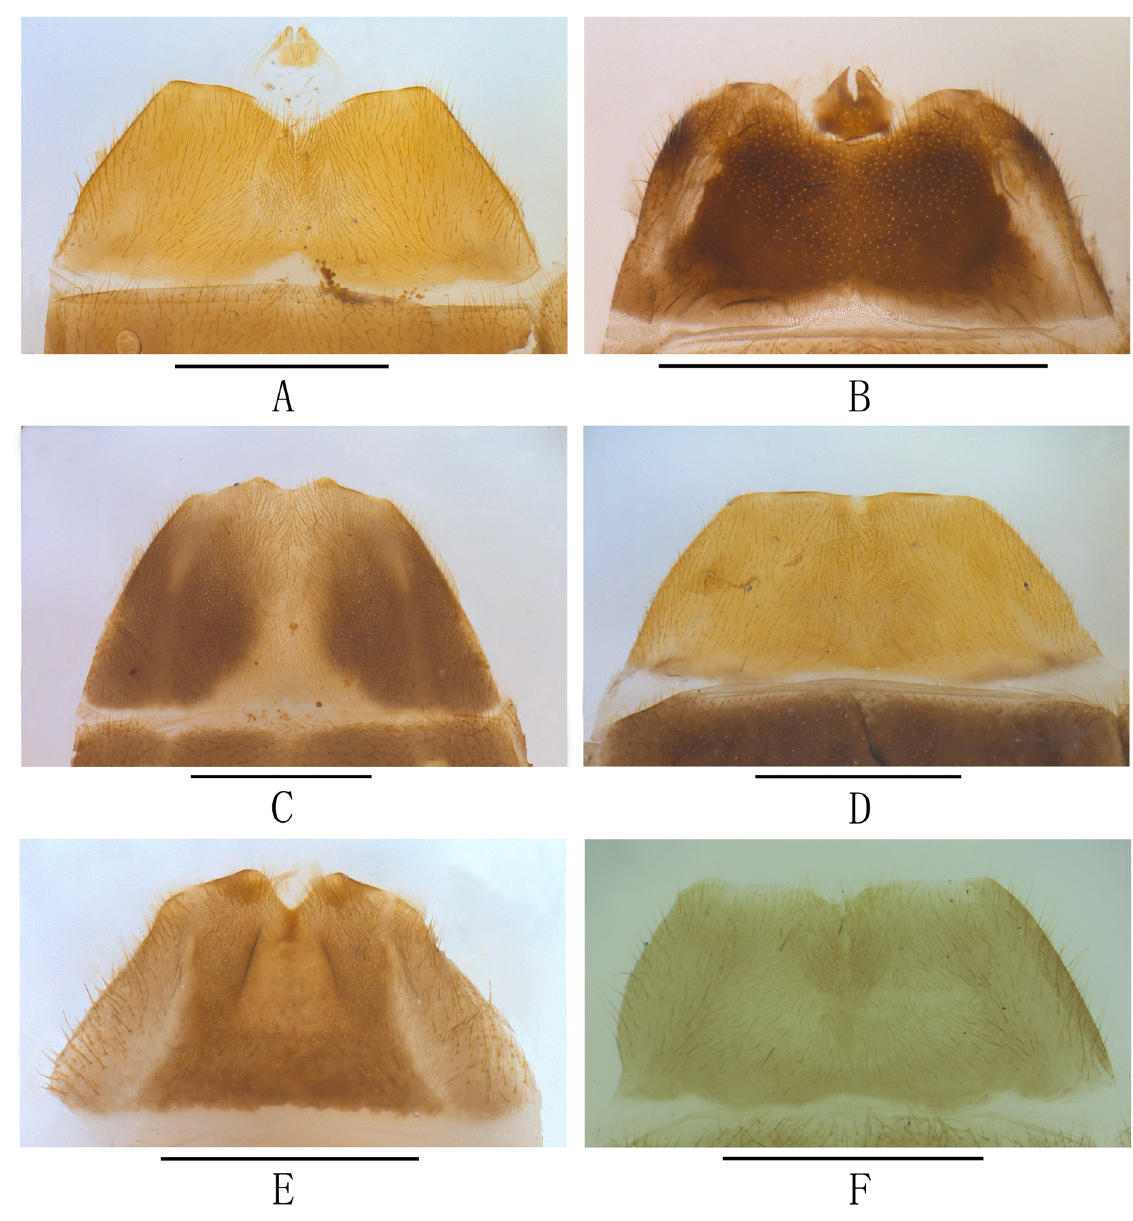
Fig. 3. Abdominal sternite VIII of female, ventral view. A . Stenothemus shaanxiensis Švihla, 2004 stat. nov. (IZAS, Shaanxi). B . S . davidi (Pic, 1926) comb. nov. (IZAS, Shaanxi). C . S . diffusus Wittmer, 1974 (MHBU, Sichuan). D . S . dundai Švihla, 2004 (MHBU, Sichuan). E . S . grahami Wittmer, 1974 (IZAS, Gansu). F . S . jindrai Švihla, 2004 (IZAS, Sichuan). Scale bars = 1.0